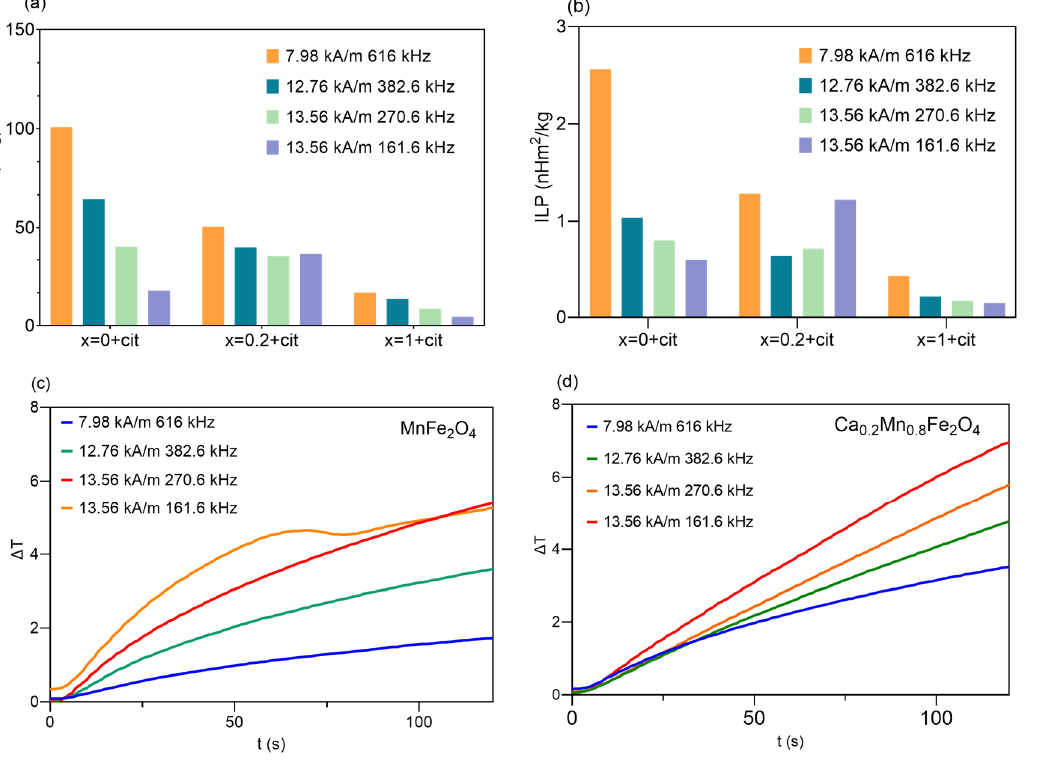
Figure 4. Values of SAR ( a ), ILP ( b ) of citrate-functionalized NPs and variation of temperature (ΔT) over time (t) of MnFe 2 O 4 ( c ), and Ca 0.2 Mn 0.8 Fe 2 O 4 NPs ( d ), under an AMF at different conditions below the biological acceptance limit (H AC × f= 2 × 10 9 A m −1 s -1 ). Abbreviations: x = 0 + cit, x = 0.2 + cit and x = 1 + cit are citrate-functionalized MnFe 2 O 4 , Ca 0.2 Mn 0.8 Fe 2 O 4 , and CaFe 2 O 4 nanoparticles, re- spectively.